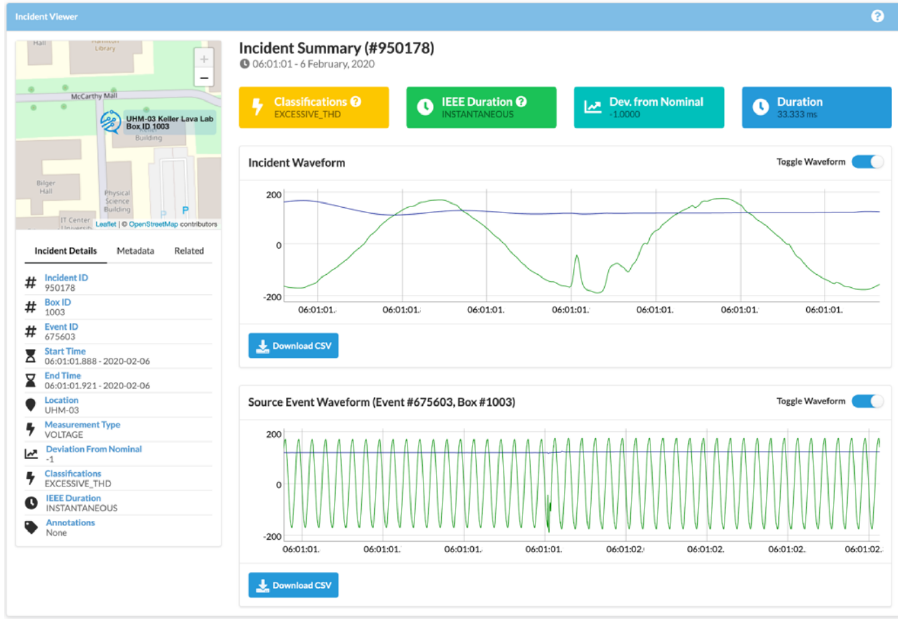
Figure 8. OPQ View: Incident